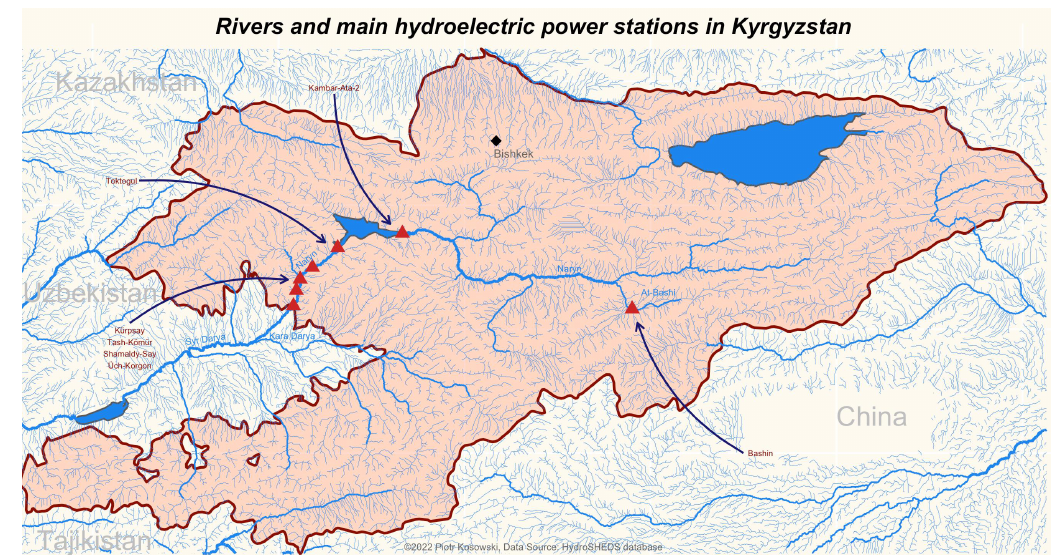
Figure 10. Rivers and main hydroelectric power stations in Kyrgyzstan.